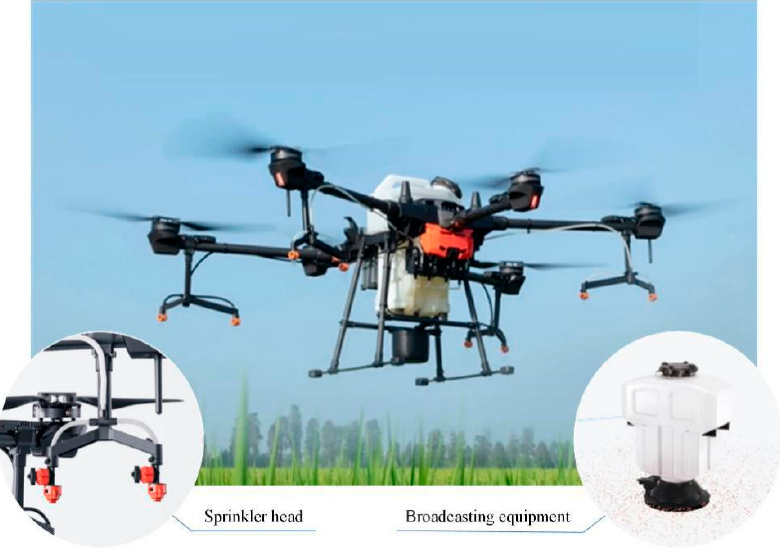
Figure 9. DJI T20 plant protection unmanned aerial vehicle (UAV) (Source: DJI).